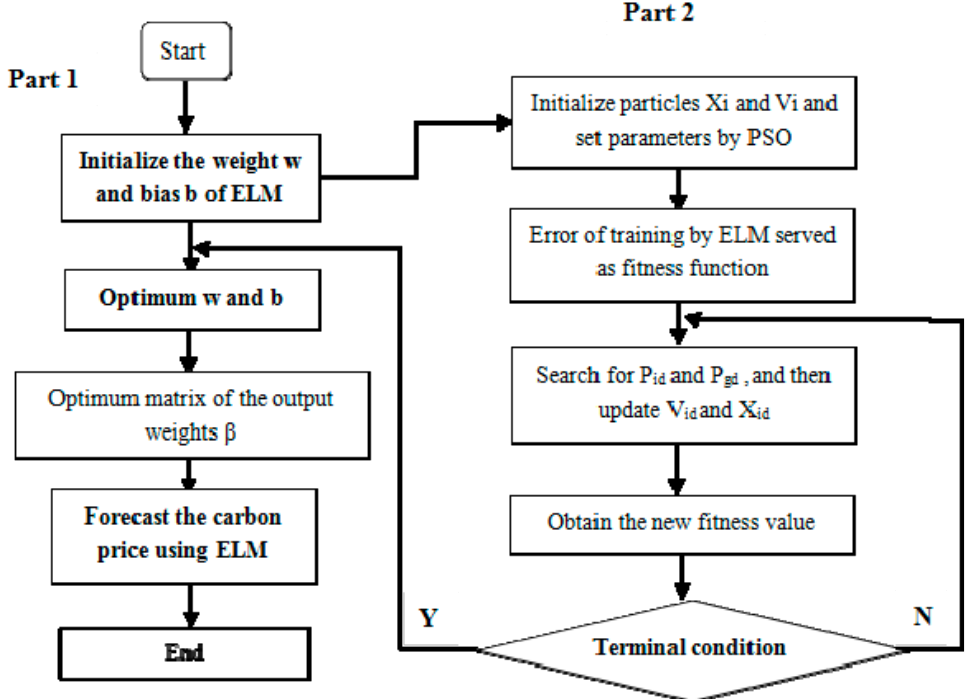
Figure 2. The flow chart of the particle swarm optimization (PSO)-ELM model.